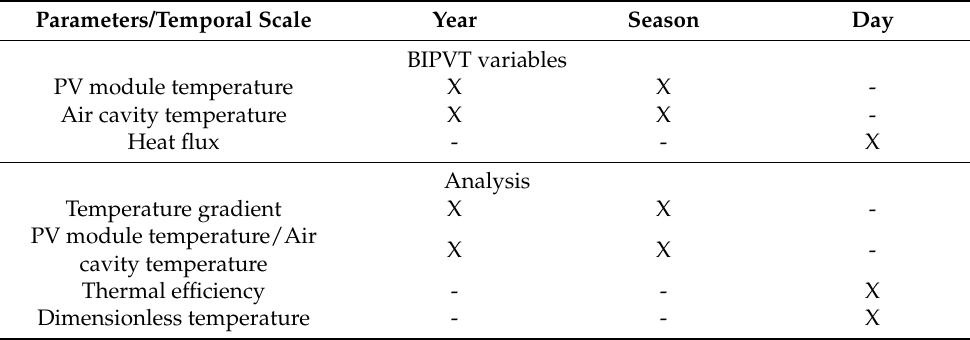
Table 4. Temporal scale of the